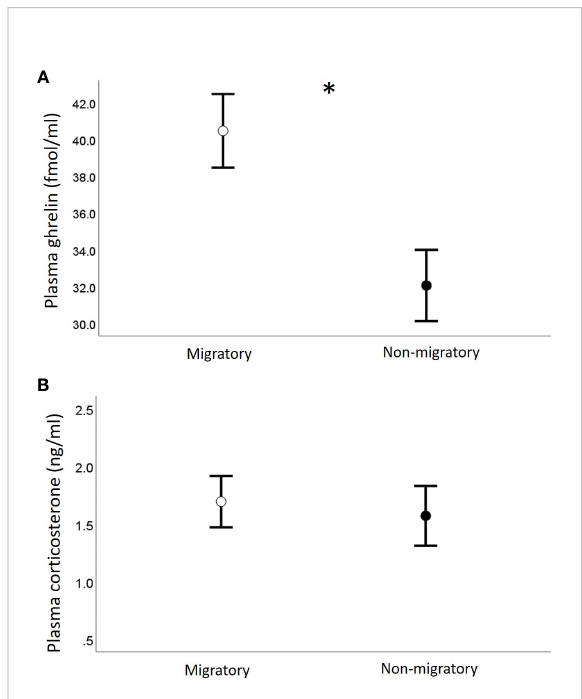
FIGURE 2 Concentrations of plasma ghrelin (A) and plasma corticosterone (B) in relation to sampling phase. Data are shown as mean ± se; * indicates p <